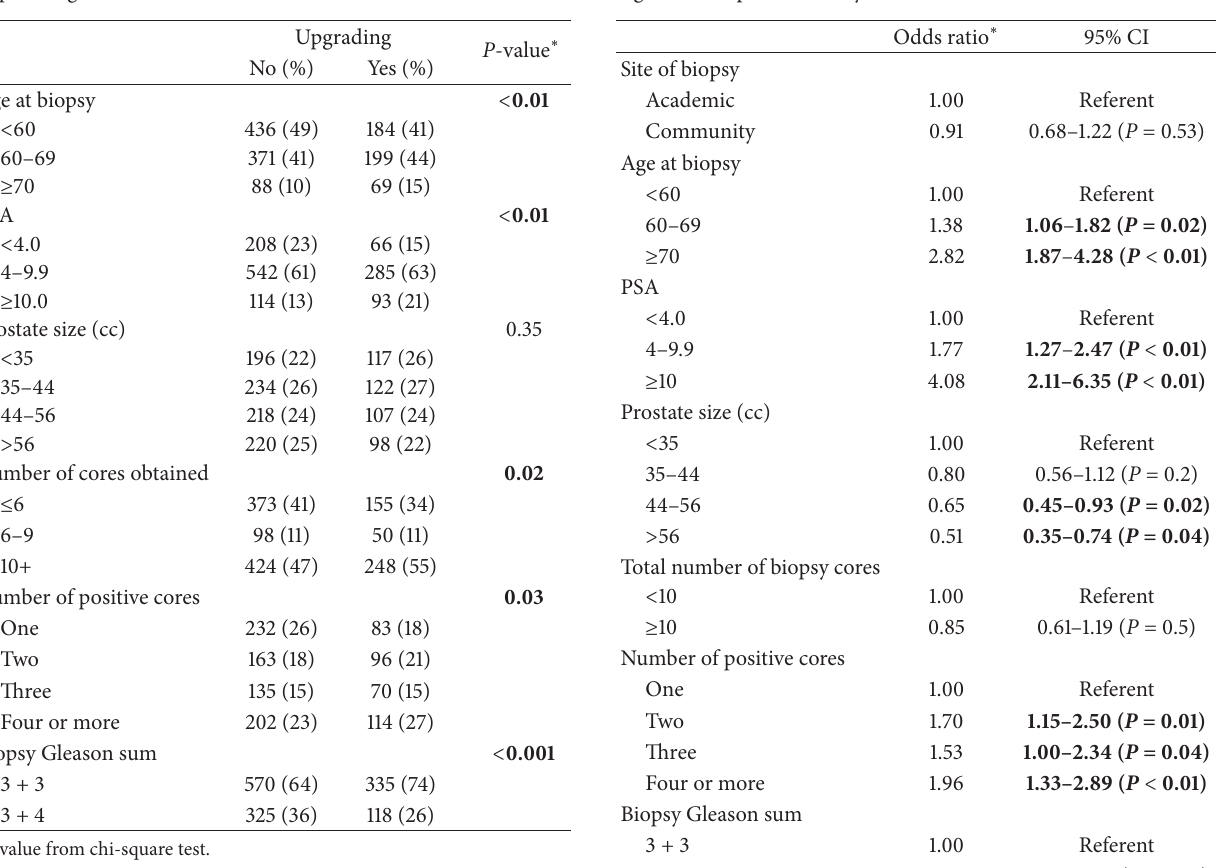
Table 2: Proportion of cases with Gleason upgrading at RP based on pathologic and clinical characteristics.